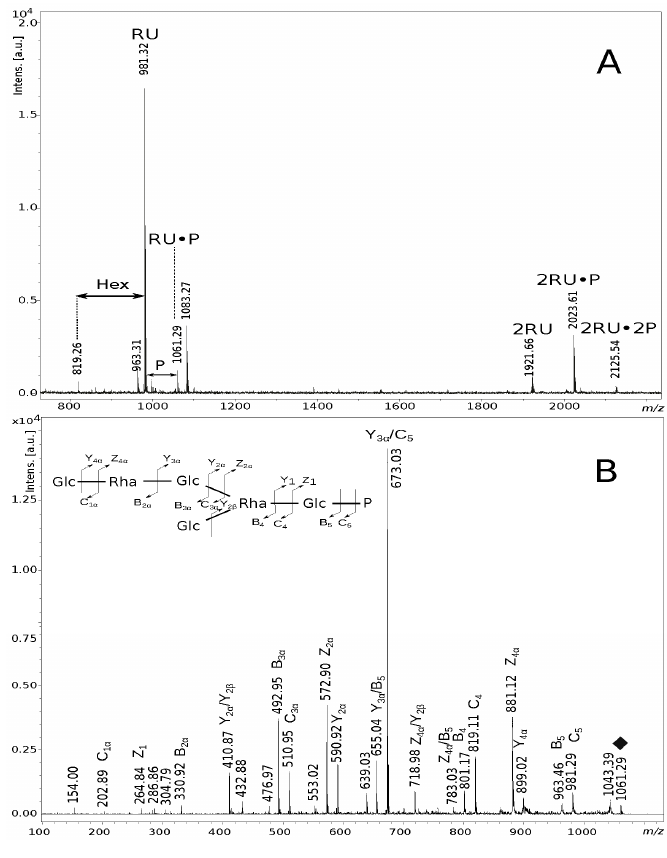
Figure 4. Positive ion mode MALDI-TOF mass spectra of the partially hydrolysed EPS ( A ), and the MS/MS fragmentation of the ion at m / z 1061.29 (1+) attributed to the hexasaccharide repeating unit linked to phosphate group accompanied by the EPS inset structure explaining interpretation of the fragment ions ( B ). The RU·P and RU symbols stand for the one repeating unit of the EPS with or without P, respectively. The m / z values represent single charged ions. The fragment ions were presented according to the nomenclature of Domon and Costello [19].